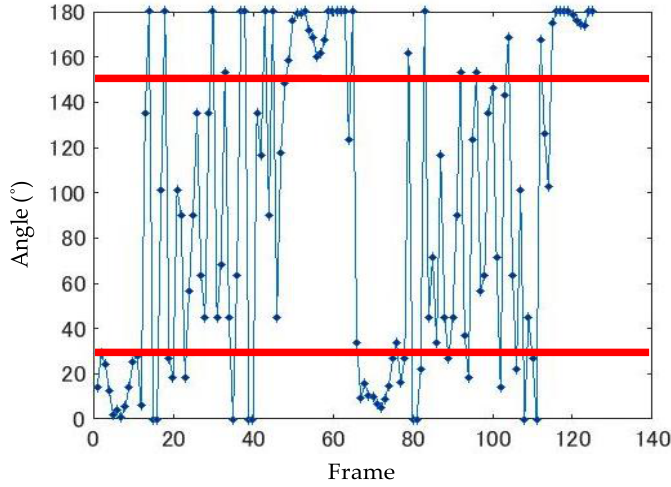
Figure 6. Angle of finger movement.